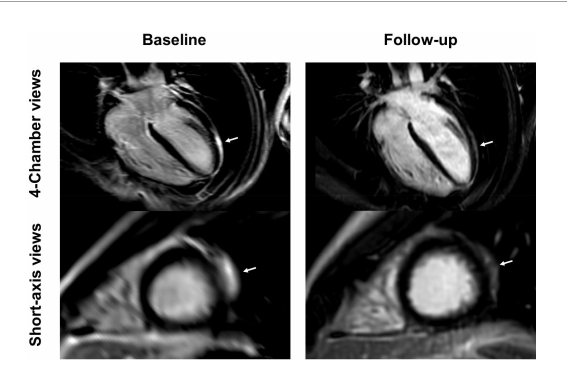
FIGURE7 4-chamber and short-axis late gadolinium enhancement (LGE) views of a 15-year-old male after receiving the second dose of the Pfizer/BioNTech vaccine. Subepicardial and pericardial LGE at the apical lateral wall (arrows) shows a marked decrease at the 9-month follow-up with residual findings. Resolution of chest pain at follow-up was accompanied by new onset of occasional exertional